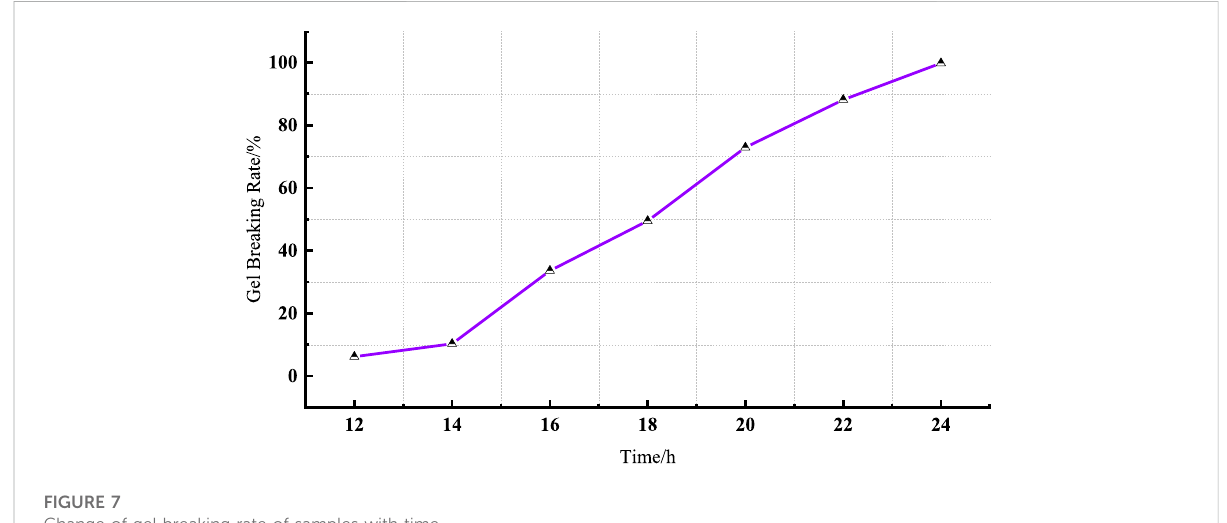
FIGURE 7 Change of gel breaking rate of samples with